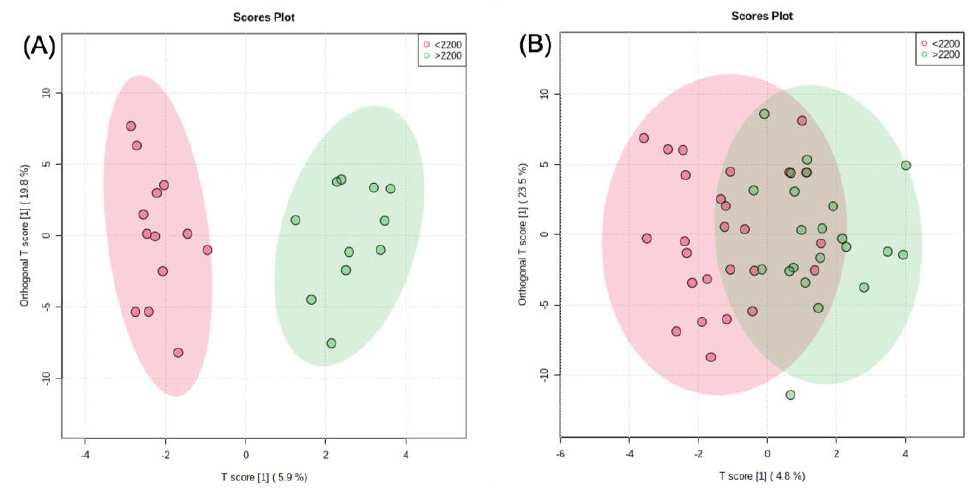
Figure 4. Log-transformed OPLS-DA models distinguishing metabolic phenotype of a low calorie (<2200 kcal/day) group and a high calorie (>2200 kcal/day) group. The two score plots represent ( A ) men and ( B ) women.